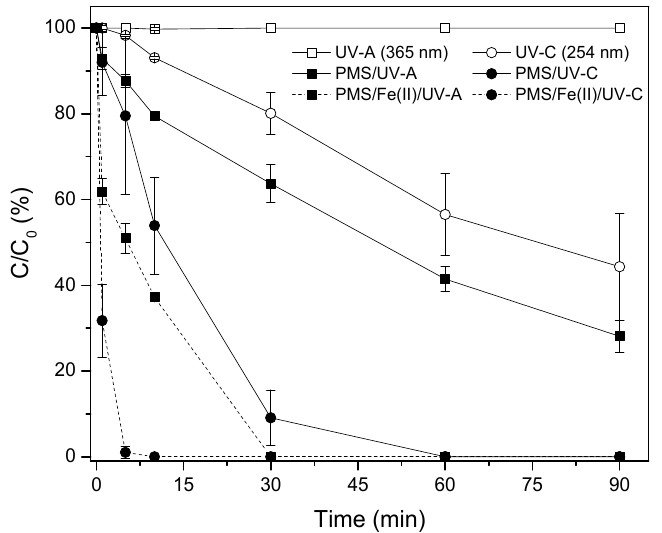
Figure 2. MB discoloration (%) through the PMS/Fe 2+ system, under UV-A and UV-C radiation. [PMS] = 500 mg/L; [Fe 2+ ] = 28 mg/L.